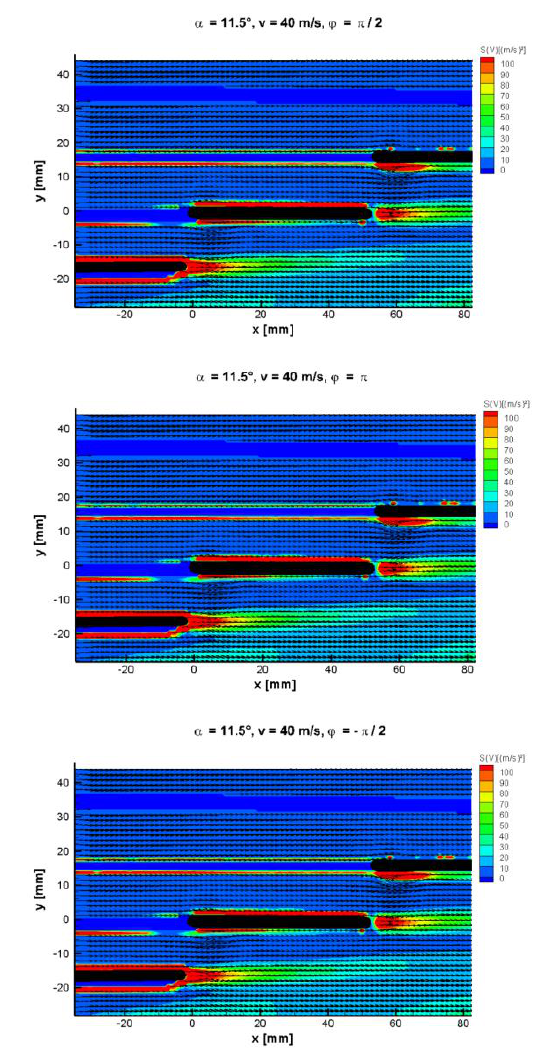
Fig. 4a, b, c, d. Velocity variances. Comparison of four distinct phase angles ϕ=0, π/2, π, - π/2.